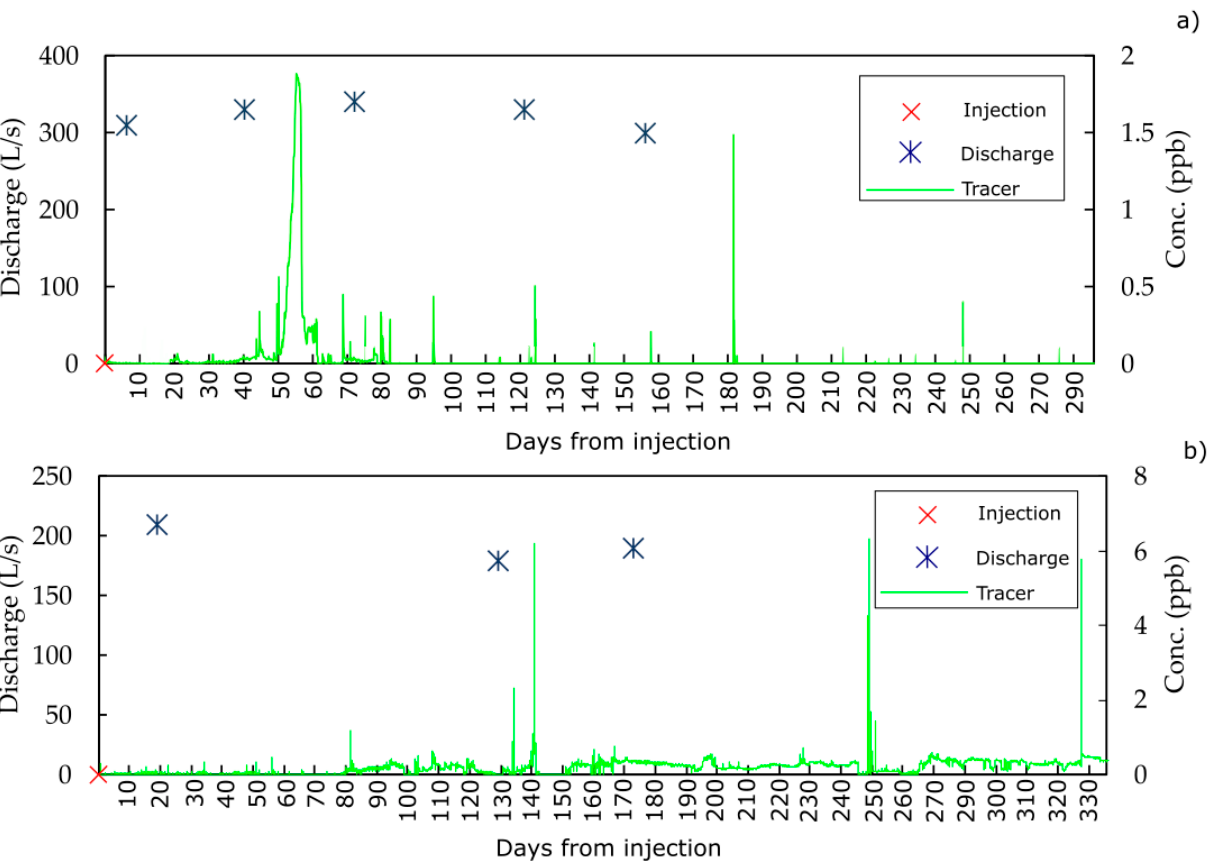
Figure 7. Tracer Breakthrough Curves of ( a ) TEST4 and ( b ) TEST5. The principal vertical axes refer to the discharge recorded in St1 while the secondary vertical axes refer to the tracer concentrations expressed in ppb.